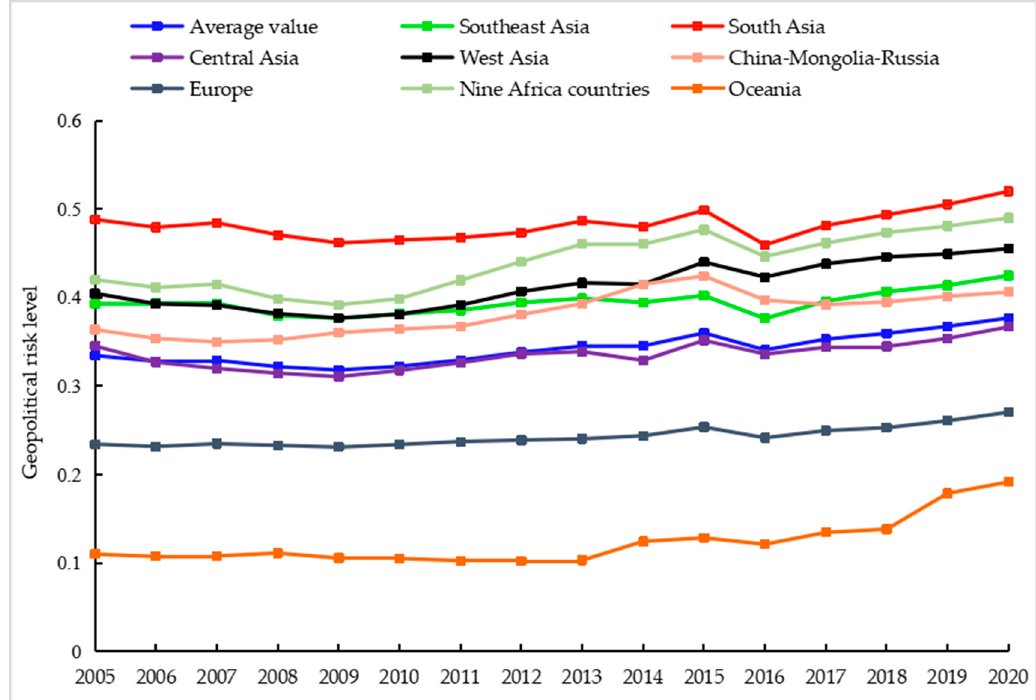
Figure 2. Changes in geopolitical risk in regions along the Belt and Road from 2005 to 2020.